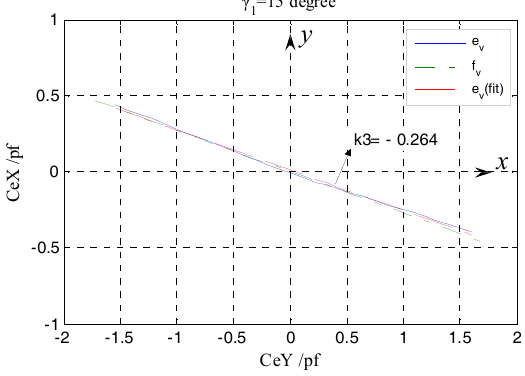
Figure 28. The curve of CeX/CeY as tilting under single yaw angle.